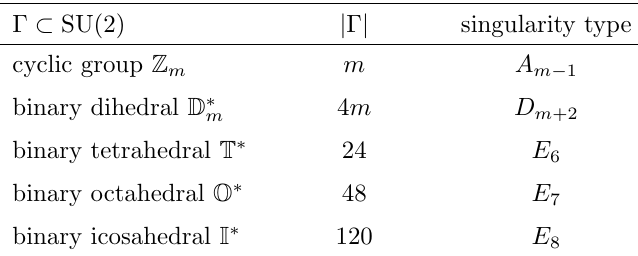
Table 1 . The freely acting discrete subgroups of